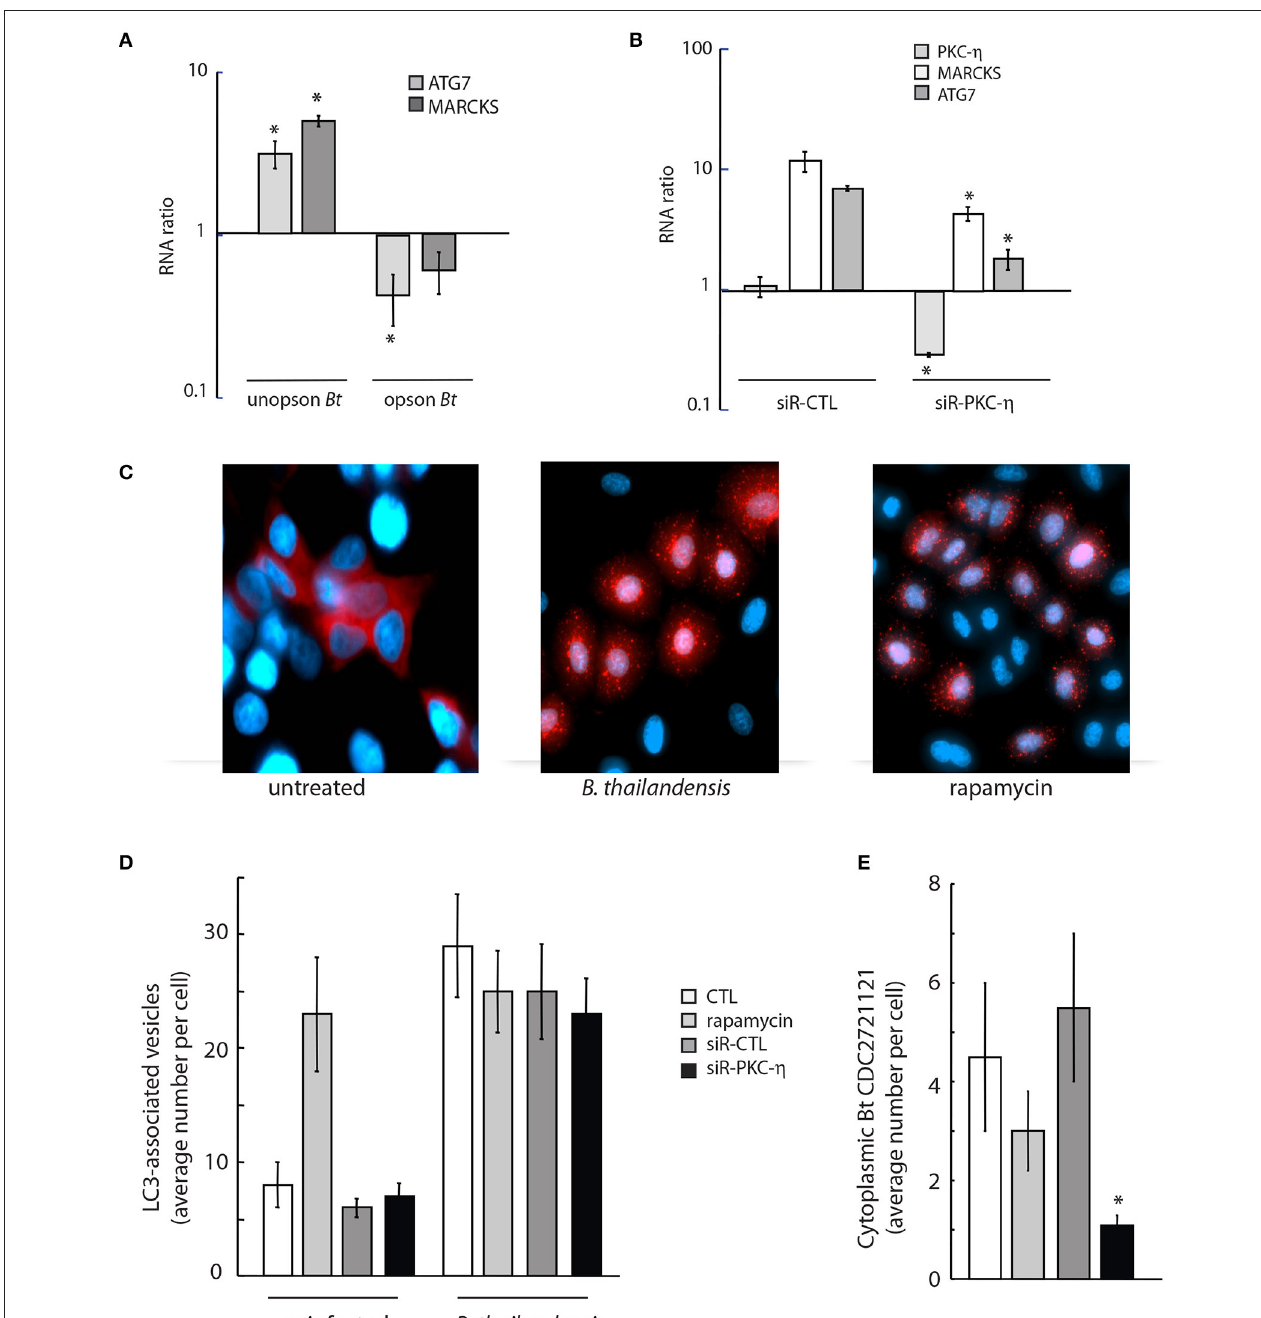
FIGURE 6 | Downregulation of PKC- η gene expression results in reduced cytoplasmic Burkholderia load and autophagy initiation. (A) A549 cells were infected with unopsonized or serum-coated Bt CDC2721121 (opson Bt ) at MOI 50. Total RNA was isolated 5 h post infection, and transcript levels of ATG7 and MARCKS were quantified in infected vs. uninfected cells. The average and standard deviation from three independent experiments are shown. The “*” denotes statistical significance ( p < 0.05) for RNA expression in infected host cells compared to uninfected samples. (B) A549 cells were treated with 20 nM siRNA targeting PKC- η or control siRNA (siR-CTL) for 72 h and then infected with unopsonized Bt CDC2721121 at MOI 50. Total RNA was isolated 18 h post infection and changes in gene expression profiles of PKC- η , MARCKS, and ATG7 were quantified relative to uninfected cells. The average and standard deviation from three independent experiments are shown. The “*” denotes statistical significance ( p < 0.05) for RNA expression in samples treated with siR-PKC- η compared to their cognate samples treated with control siRNA. (C) A549 cells stably expressing RFP-LC3B were infected with unopsonized Bt CDC2721121 at MOI 50 for 6 h or treated with 0.5 µ M rapamycin and analyzed by fluorescent microscopy to image LC3-positive autophagosomes. Scale bar, 10 µ m. (D,E) Quantifying autophagosomes and cytoplasmic Bt CDC2721121 in lung epithelial cells with imaging flow cytometry. A549-RFP-LC3B cells were treated with 20 nM siRNA against PKC- η or non-targeting siRNA (siR-CTL) for 72 h prior